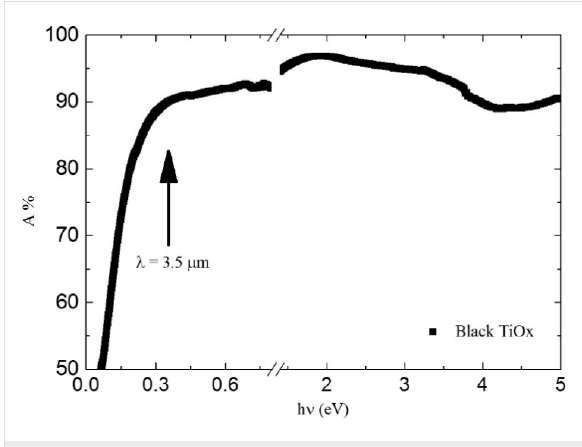
Figure 5: Absorbance spectra of the TiO x /Ti film in the IR, visible and UV spectral range.